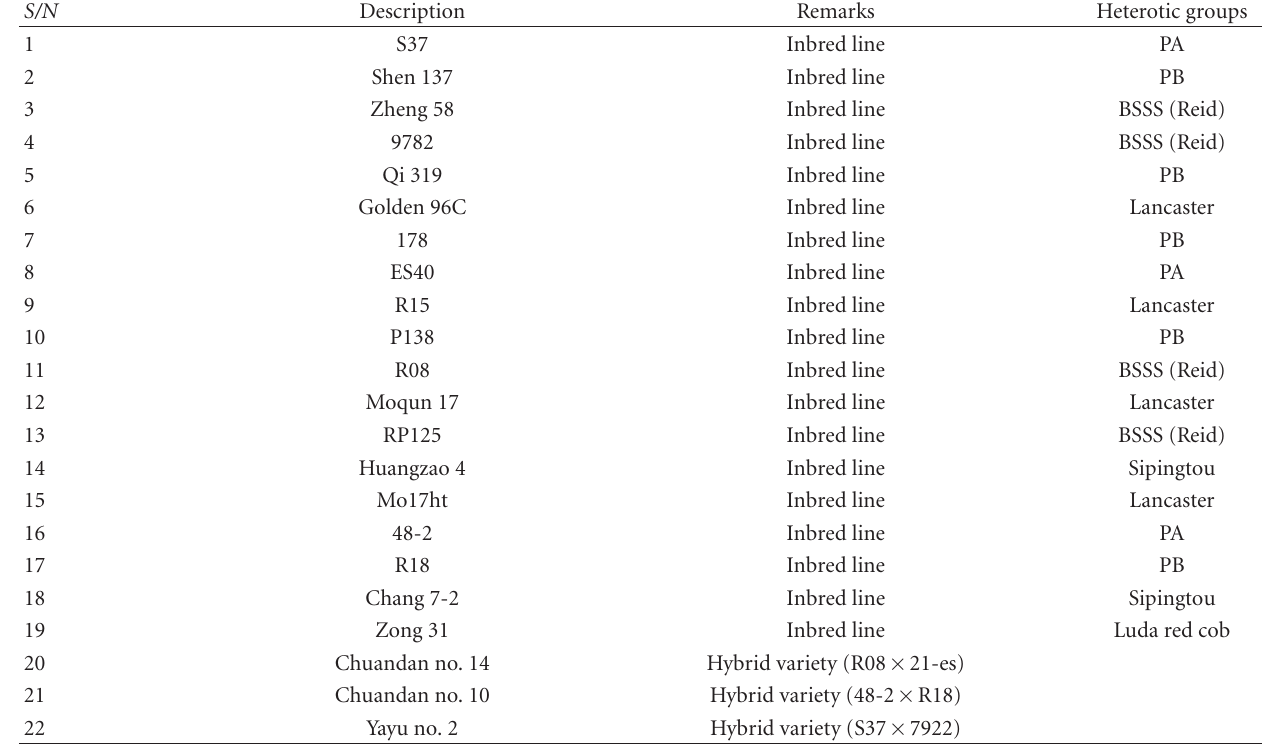
Table 1: Inbred lines and hybrid